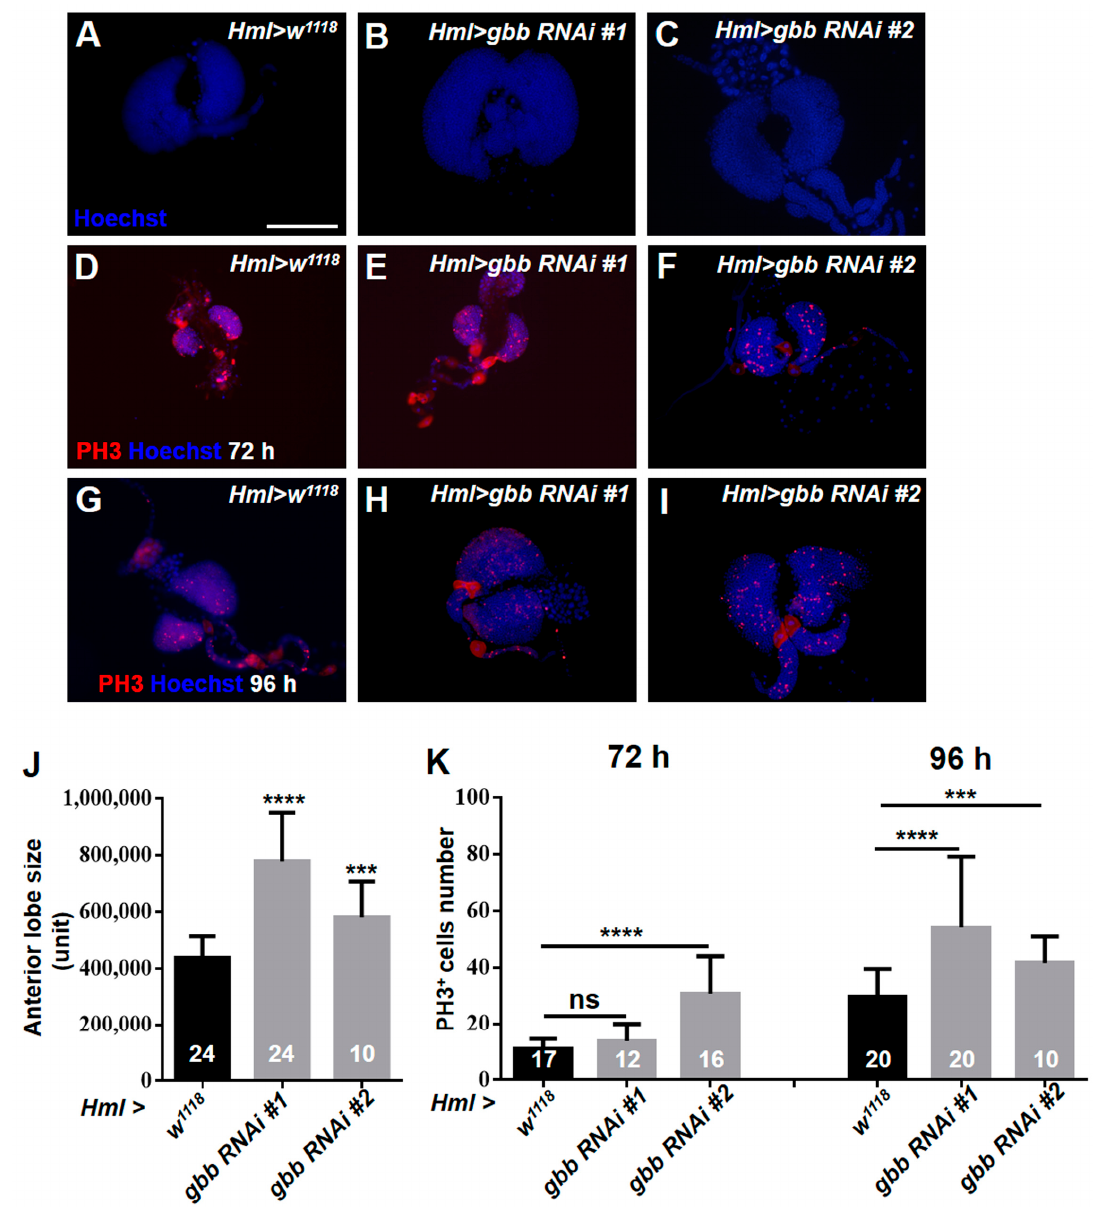
Figure 6. The loss of Gbb in the CZ induces the hyperproliferation of lymph glands. ( A – C ) Immunostaining of lymph glands with Hoechst showed that the anterior lobes of Hml > gbb RNAi#1 and Hml > gbb RNAi#2 lymph glands were obviously enlarged. ( D – I ) Immunostaining of lymph glands with anti-PH3 antibody showed increased PH3-positive cells in the Hml > gbb RNAi#1 and Hml > gbb RNAi#2 lymph glands at 72 h ( D – F ) and 96 h ( G – I ) after egg laying. ( J ) Quantification of anterior lobe size. ( K ) Quantification of PH3-positive cell number at 72 h (D–F) and 96 h ( G – I ) after egg laying. For all quantifications: NS, not significant; *** p < 0.001; **** p < 0.0001 (Student’s t test). Scale bars: 100 µ m ( A – I ).